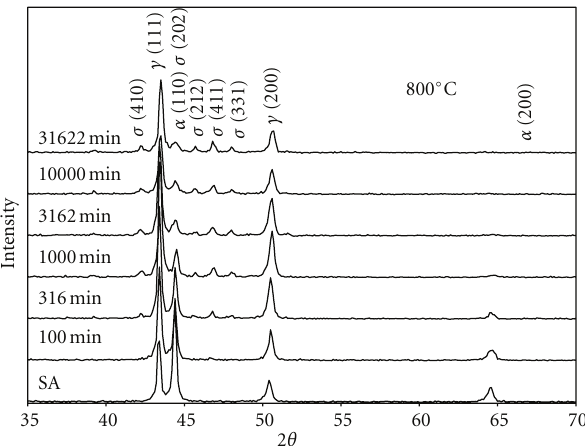
Figure 7: X-Ray di ff raction patterns of samples aged at 800 ◦